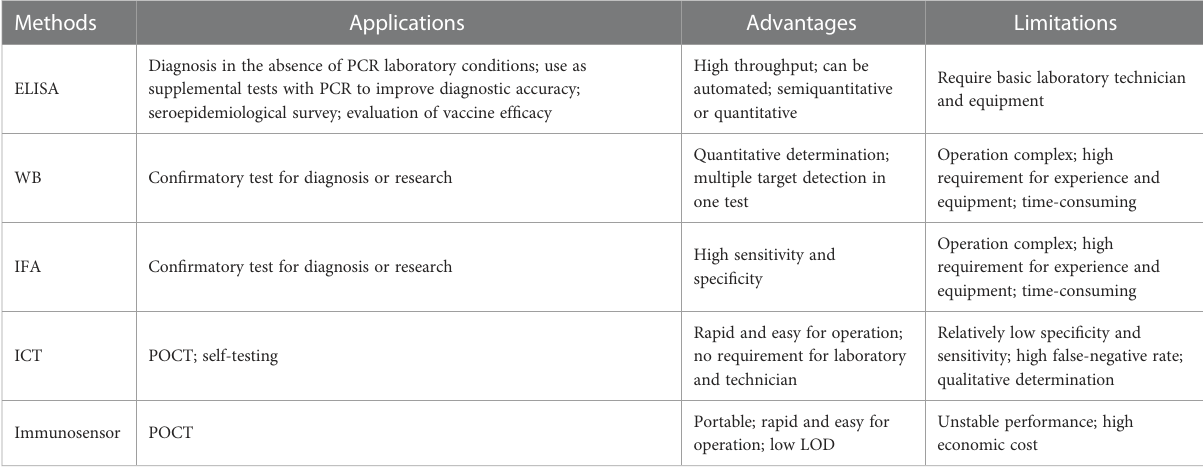
TABLE 1 Overview of mainstream immunoassays for detection of HCoVs infections.